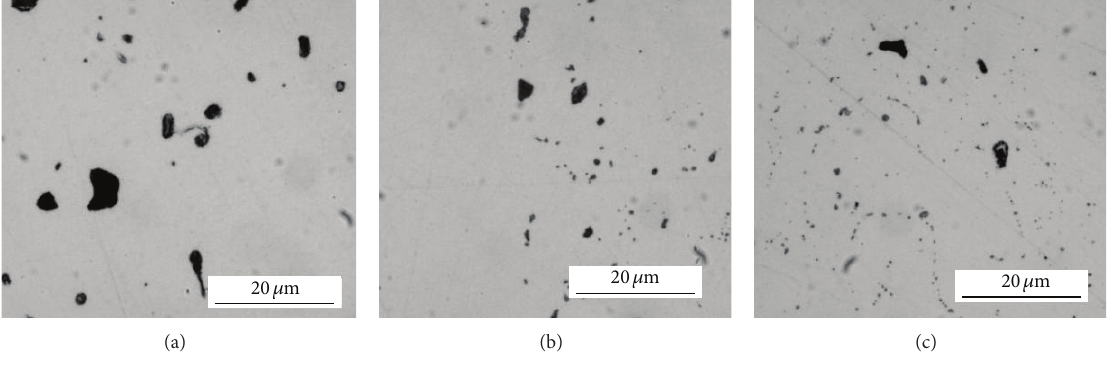
contain oxide inclusions or their agglomerates sized up to